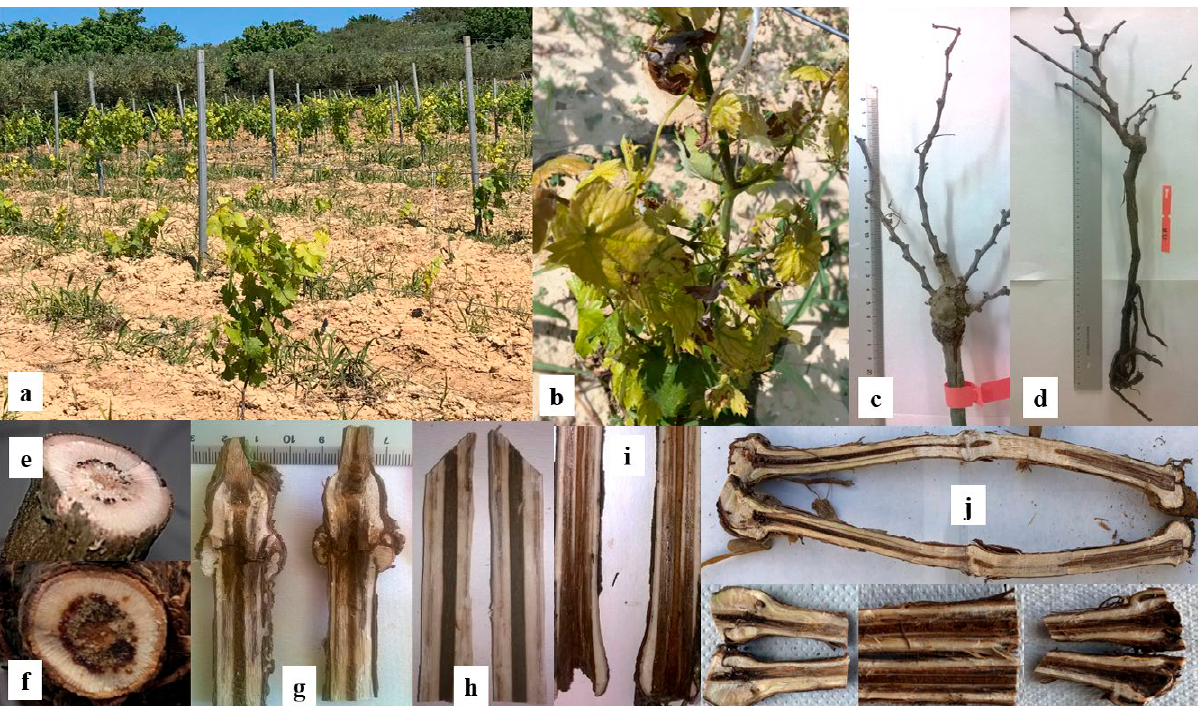
Figure 1. Symptoms of YVD observed in western Sicilian vineyards. a-d, whole plants with stunted development in cv. Muller-Thurgau (a-b) and cv. Grecanico (c-d). Vines showed delayed growth, chlorosis, canes with short internodes and poor root system development. e-j, YVD internal symptoms: dark-coloured exudates in cv. Grecanico (e), and annular browning in cv. Muller-Thurgau (f). Declining vines in longitudinal section showed wood discolouration at the grafting points (g), along the trunk (h) and at the base of the rootstock (h, cv. Gre- canico). j, longitudinal sections of vines cv.